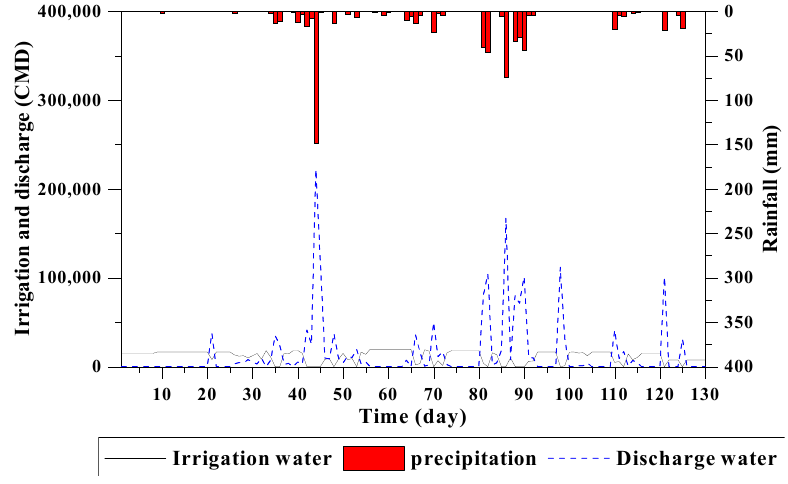
Figure 14. Irrigation, discharge, and rainfall simulation result of 30% reduction of planned irrigation water during the first crop season.